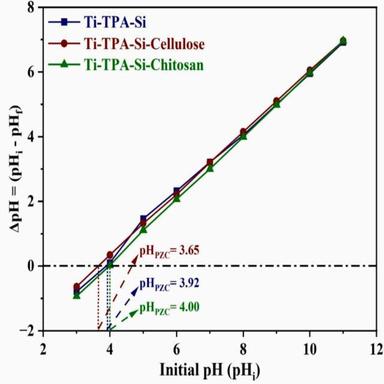
Determination of the PZC of Ti-TPA-Si, Ti-TPA-Si-C, and Ti-TPA-Si-CS.